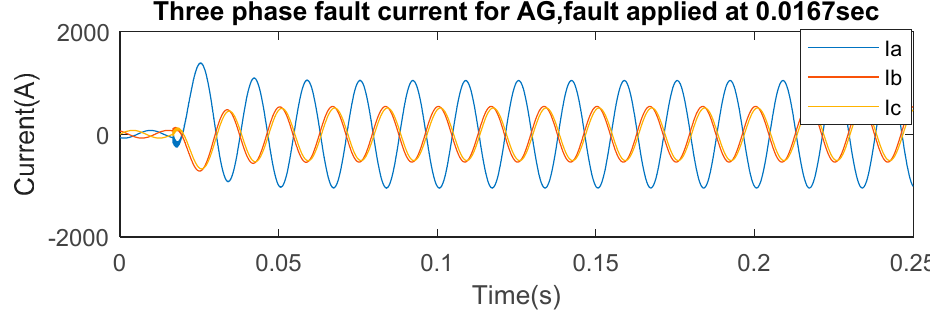
Figure 5. Useful features’ extraction from three-phase current signals and DWT: Three-phase AG (phase A to ground) fault currents measured at the sending end.